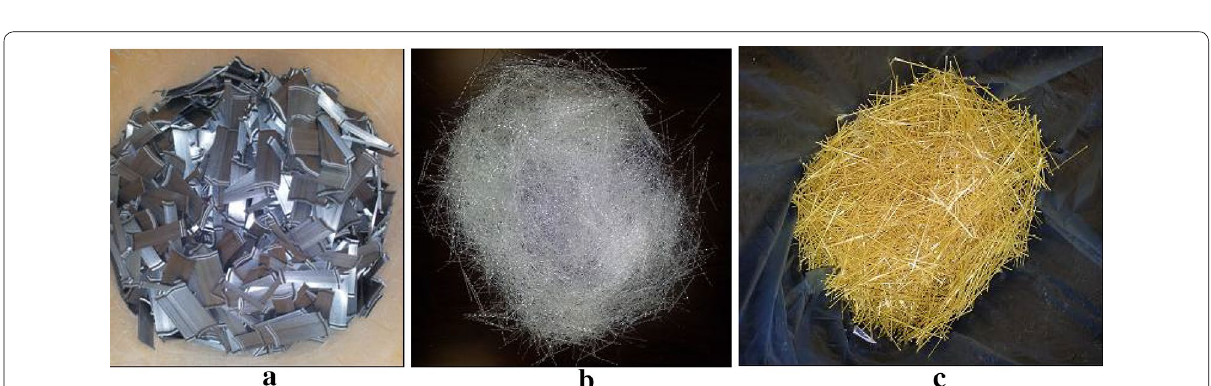
Fig. 2 a Hooked‑end steel fibers, b polypropylene fibers, and c Kevlar fibers (Almusallam et al.